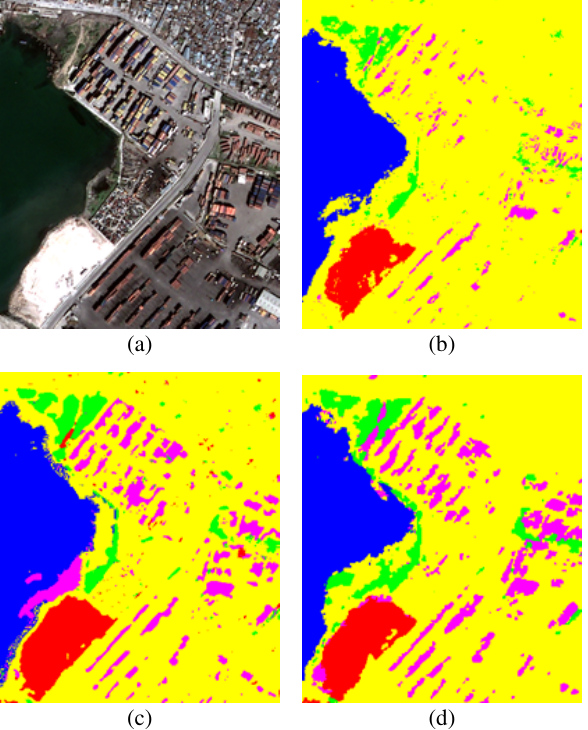
Figure 5. “Haiti” data set. Details of (a) the optical image at 1 . 25 -m resolution and of the classification maps obtained using (b) a single-resolution MRF after resampling, (c) an adaptation of the method in (Moser et al., 2016) to the case of input multisensor optical-SAR imagery, and (d) the proposed algorithm. Class legend: containers, vegetation, asphalt, Figure 4. Symmetrized scan introduced. It consists of a buildings, combination of four zig-zag scans and two Hilbert scans ( 6 steps illustrated in the figure).